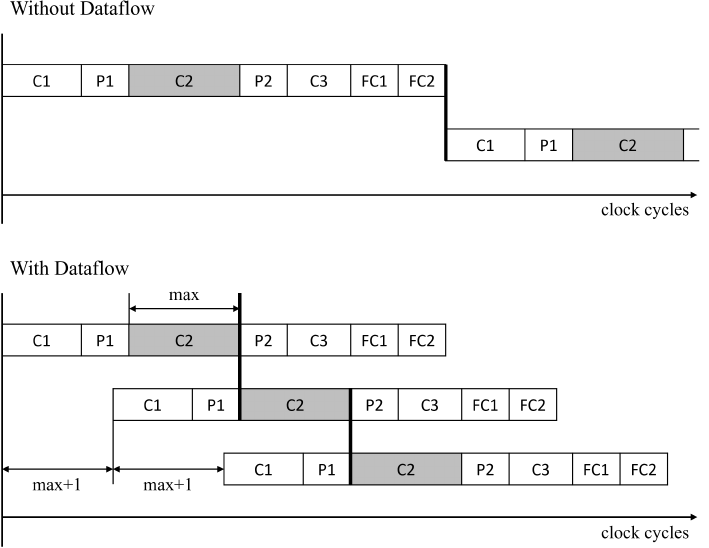
Figure 10. Pipelined network using dataflow directives.